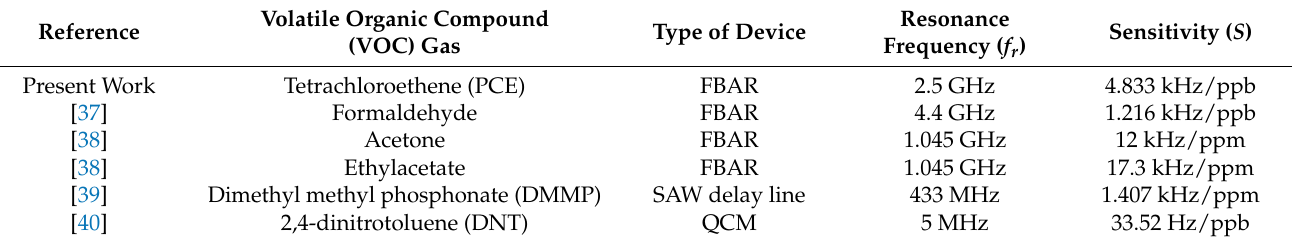
Table 6. Comparison of VOC gas sensors reported in the